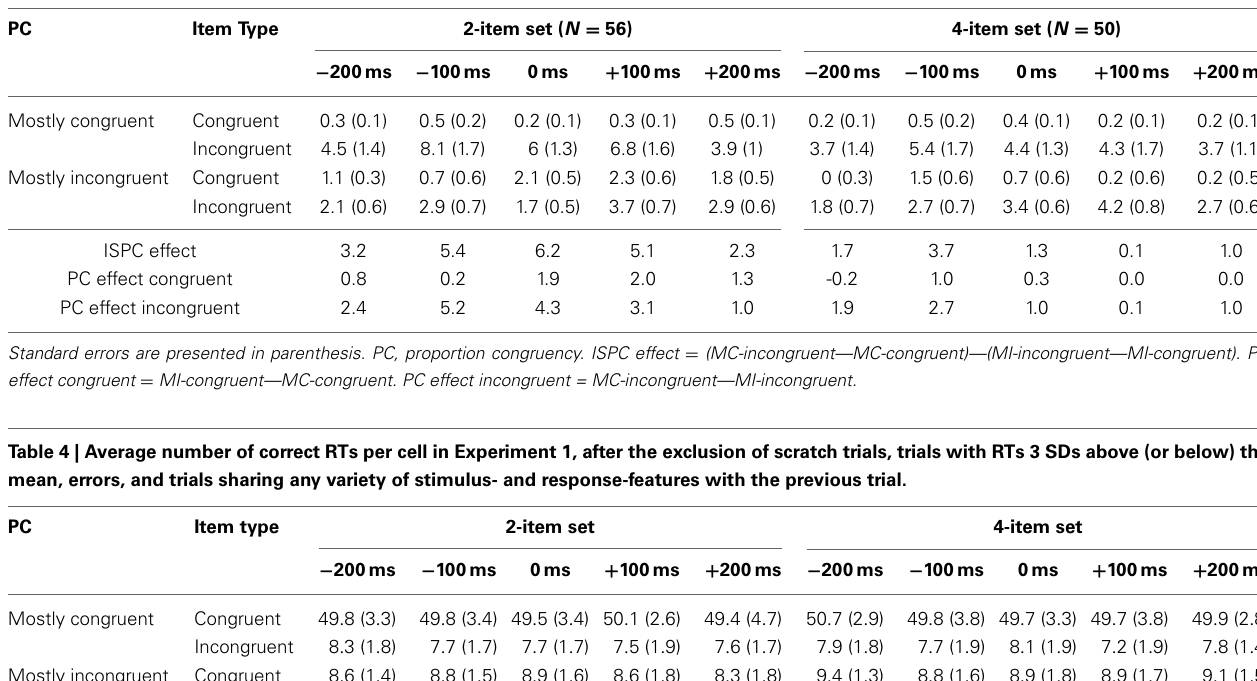
Table 3 | Percentage of errors for the conditions of Experiment 1.